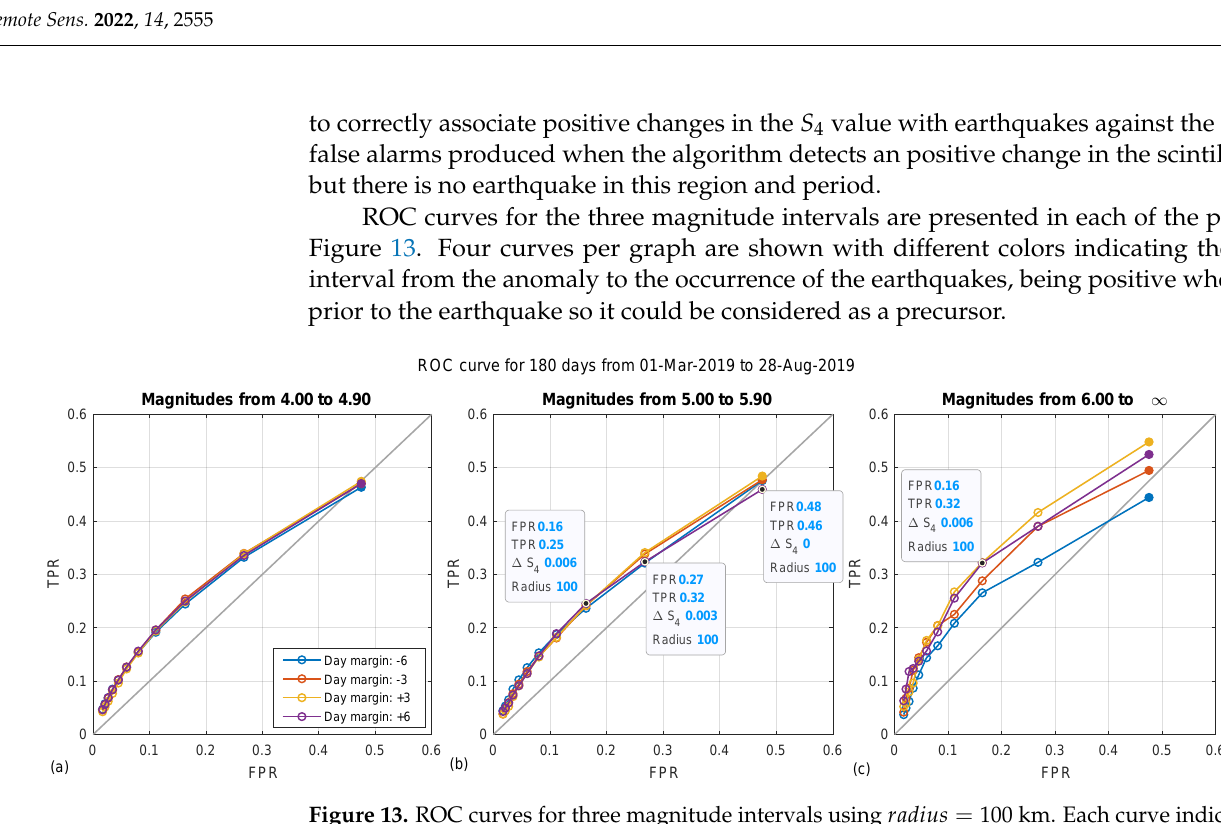
Figure 13. ROC curves for three magnitude intervals using radius = 100 km. Each curve indicated in the legend is using a different d _ margin parameter, being positive for S 4 positive increments prior to earthquakes. Points within each curve are sweeping the value of s 4_ th each 0.003 from zero in the top right